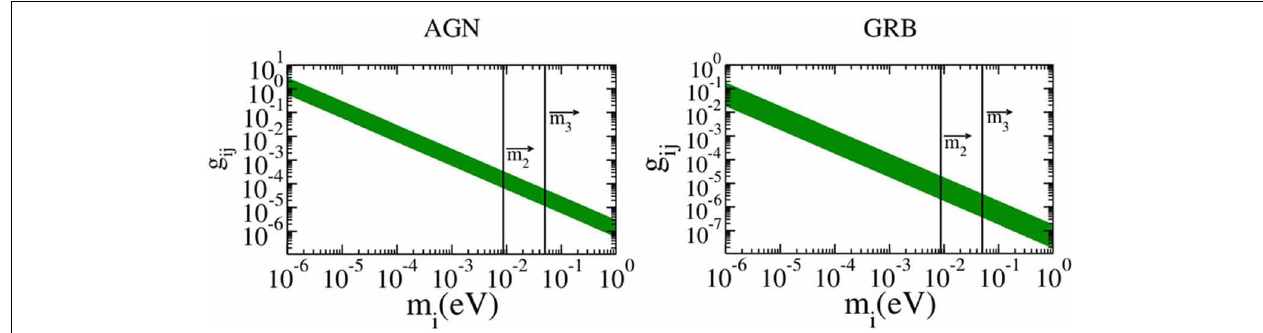
FIGURE 1 | Neutrino mass m i vs. the required coupling constant g ij for the case of AGN’s (left panel) and GRBs (right panel).